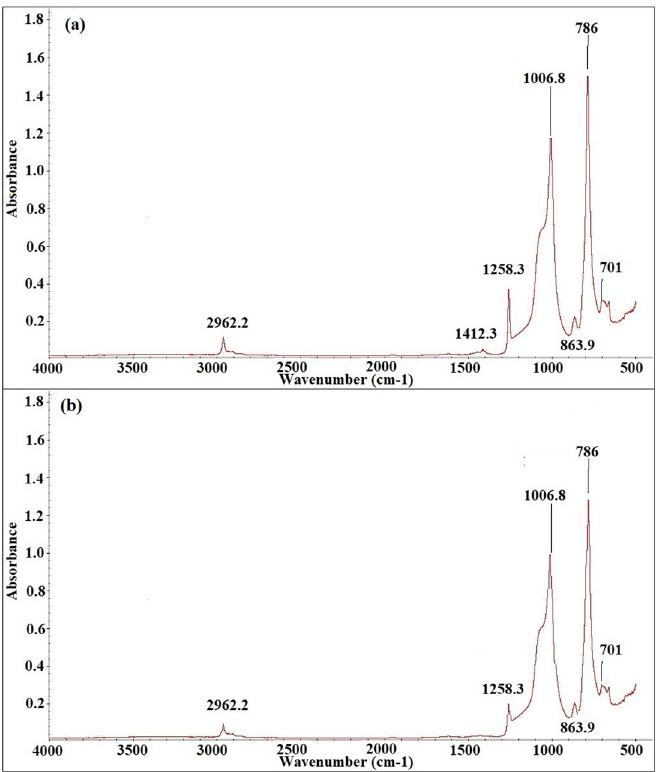
Fig 15. Spectrograph for SN8 a) Before aging, b) After